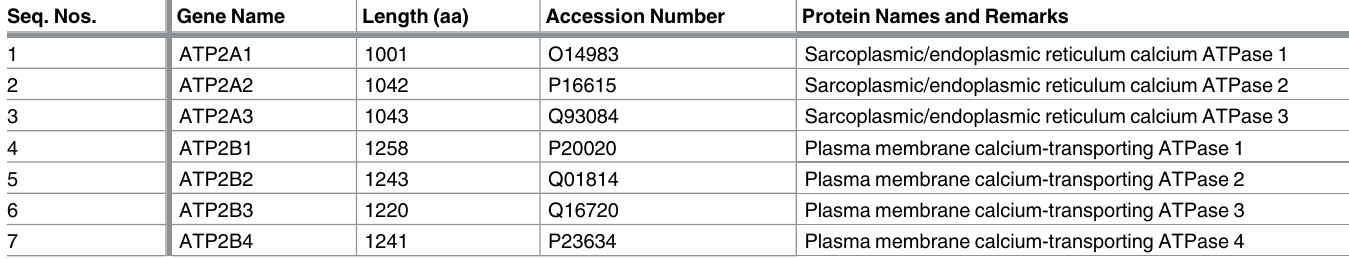
Table 9. Details of Ca 2+ -ATPase family membersin human. Seq.